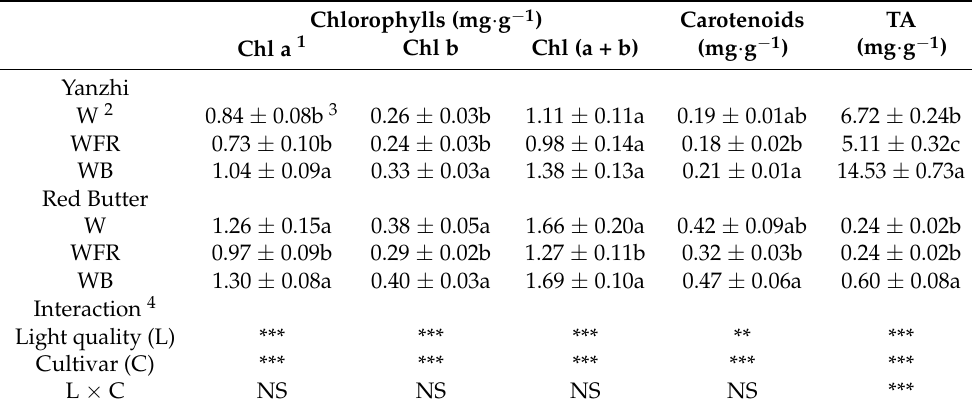
Table 4. Effects of different light quality on pigment contents of